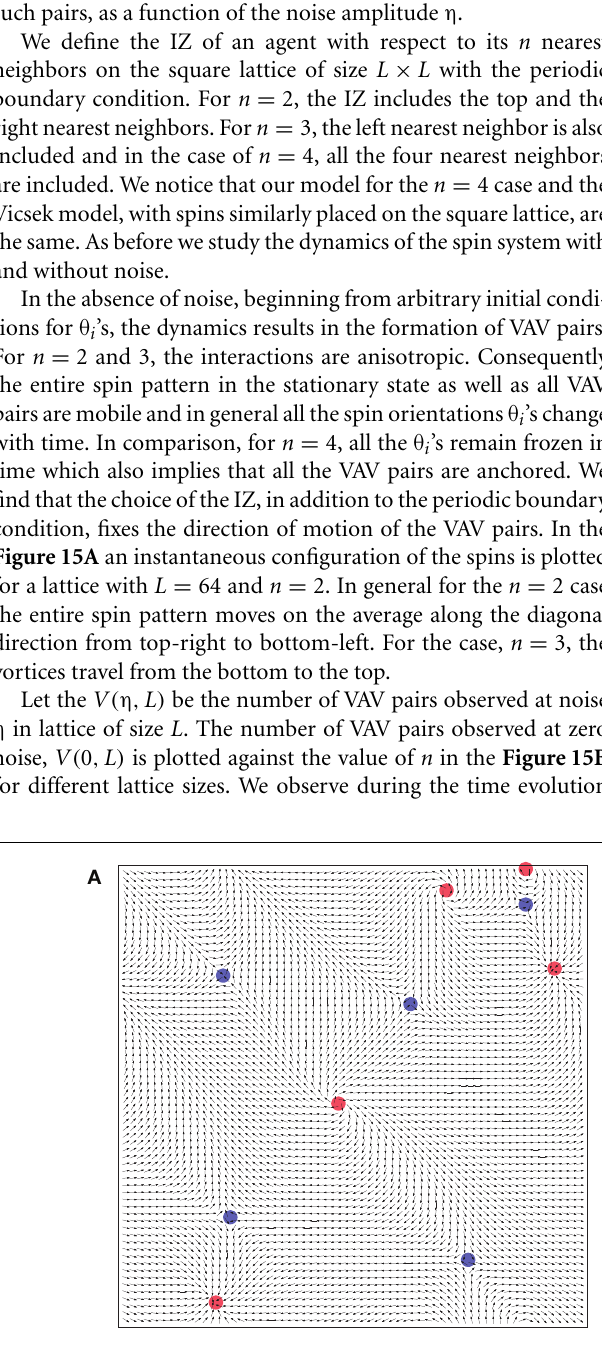
V ( 0 , L ) of vortex-antivortex pairs at zero noise for different values of n in lattices of three different sizes: L = 32 (circles), 64 (squares), and 128 (triangles). The bars indicate the standard deviation in the values obtained from around 100 configurations in each case. In the inset the percentage of configurations which lead to steady states with vortex pairs is plotted against n